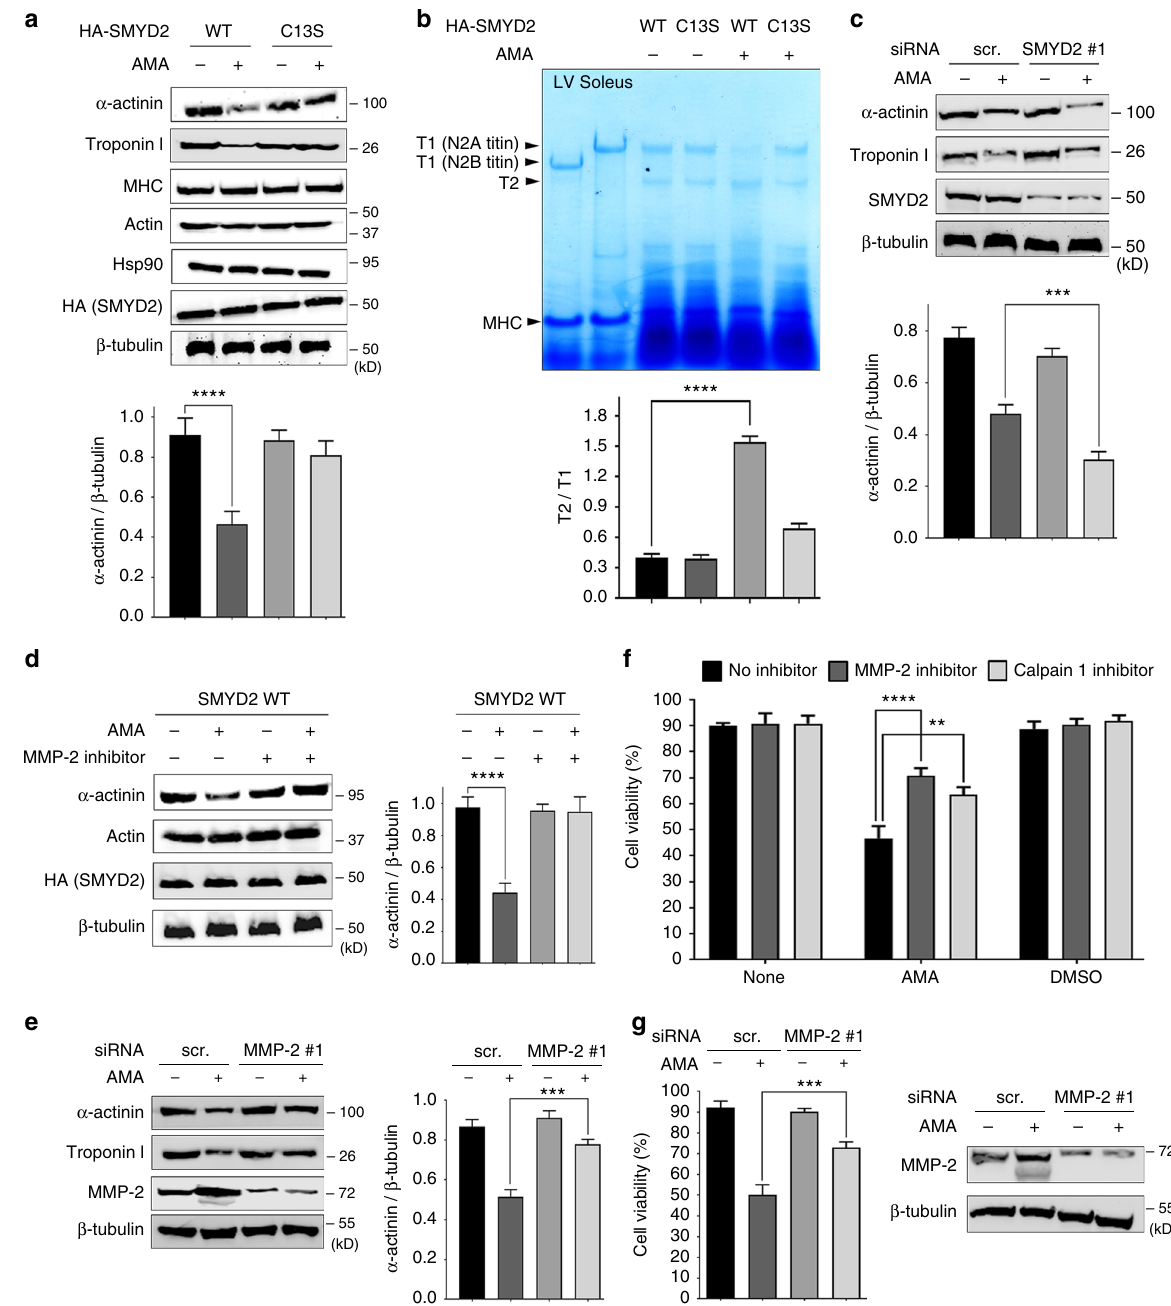
Fig. 5 SMYD2 Cys13 glutathionylation or oxidation leads to degradation of sarcomeric proteins. a Sarcomeric protein levels in response to AMA in differentiated H9c2 cells that express SMYD2 WT or C13S. b Levels of titin in response to AMA in HL-1 cells expressing SMYD2 WT or C13S. Extracts